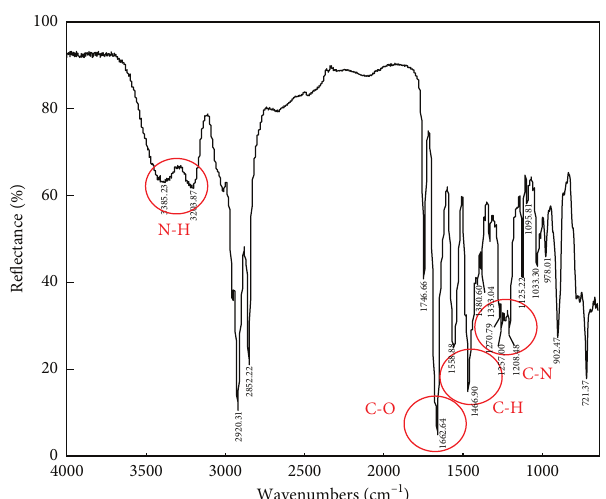
Figure 3: Synthetic product infrared spectrum.